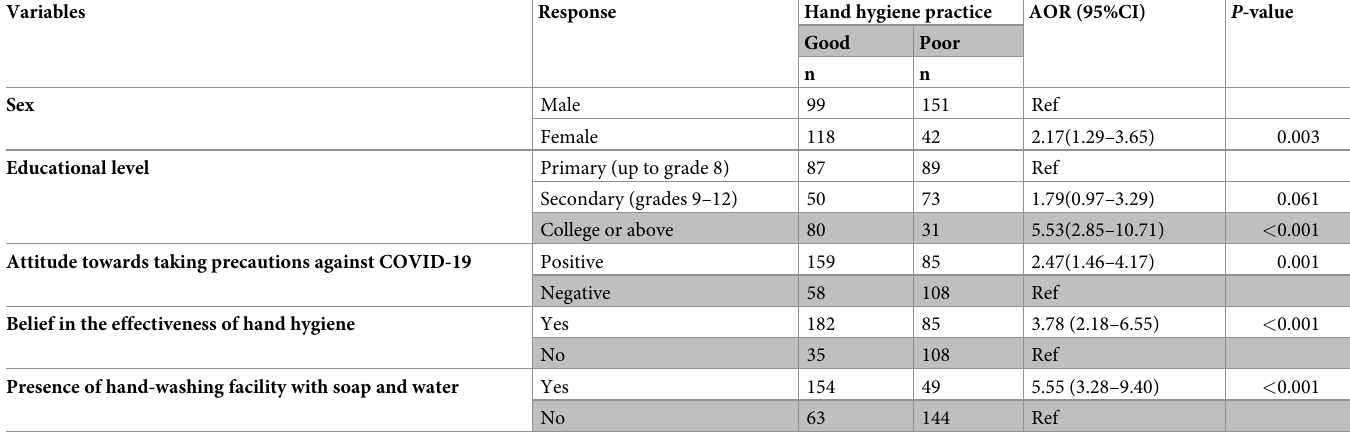
Table 7. Factors associated with good hand hygiene practice from multivariable logistic regression analysis among barbers and beauty salon workers in Dessie City and Kombolcha Town, Northeastern Ethiopia, January 5 to February 10, 2021.